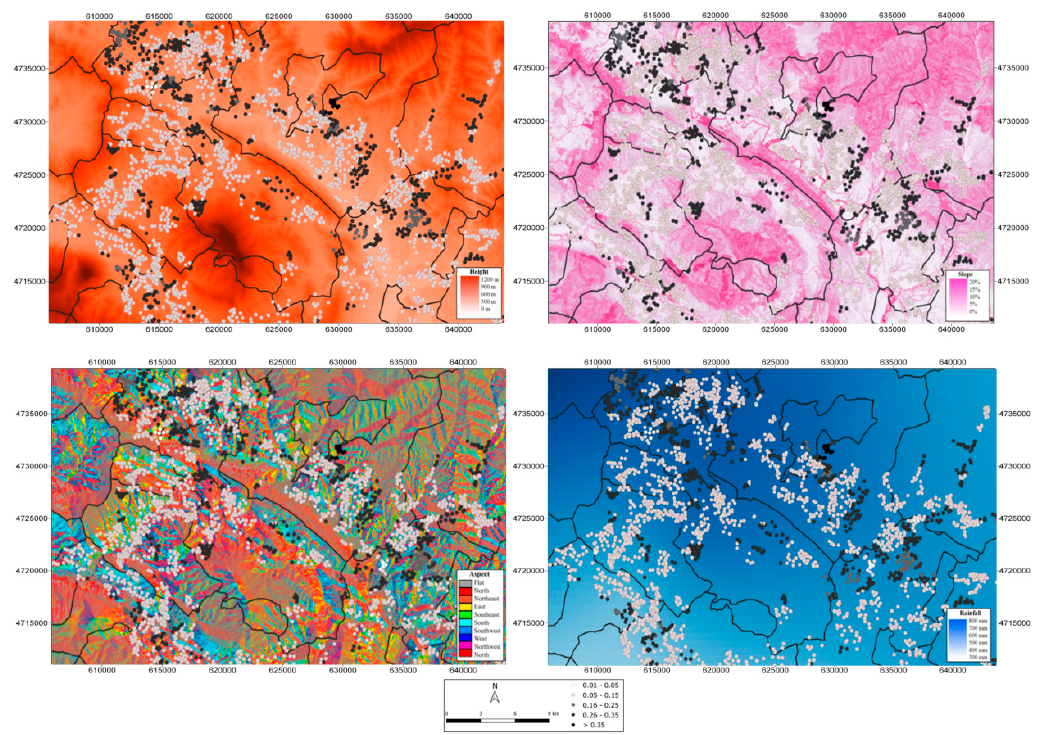
Figure 6. GWR local R 2 distribution showed on the four analyzed parameters (altitude, slope, aspect, and rainfall maps, in order from top to bottom) zoomed in to zone II (north). GWR: geographically weighted regression. UTM coordinates are expressed in meters.